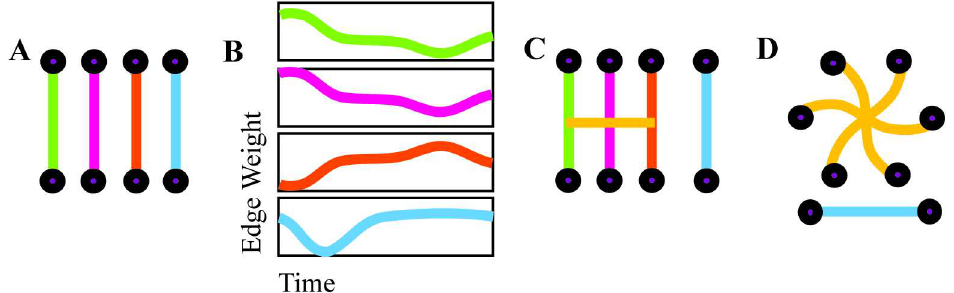
Fig 1. Hypergraph construction. An illustrationof hyperedge identification on a representational set of edges. Edge weights are computedseparately for each time window (A) and joined together to form edge weight time series (B). Significantly correlated edge time series are cross-linkedto form a hyperedge, a group of nodes that are linked by correlated edges (C). The group of hyperedges for an individual,with singletons removed, forms a hypergraph